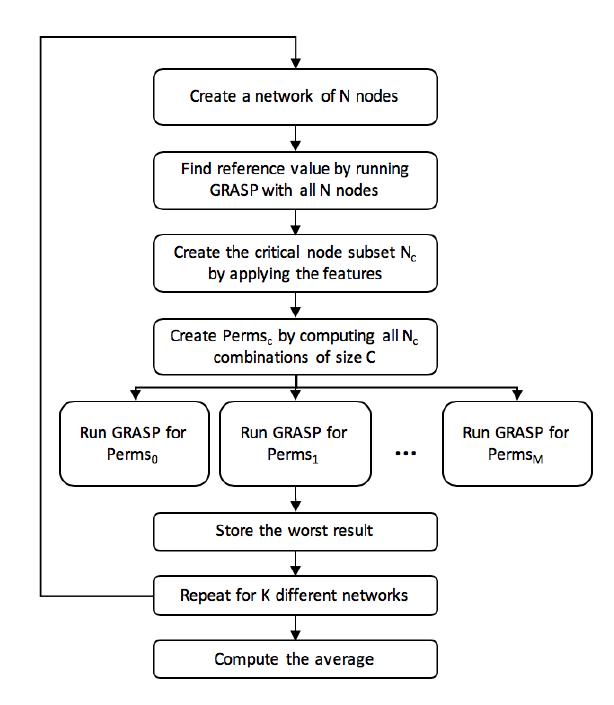
Figure 1. Framework used for the identification of critical nodes.